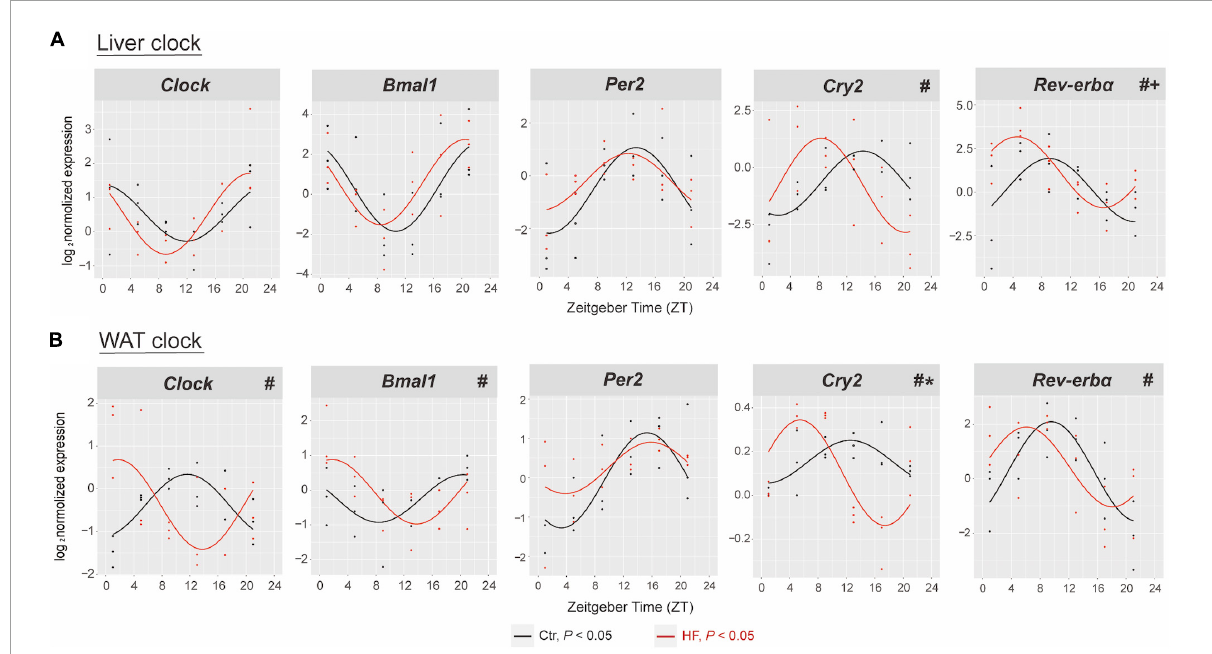
FIGURE2 High-fat diet disrupted the hepatic and adipose circadian rhythm in gestational mice. Mice were fed with a standard chow diet or a high-fat diet prior to pregnancy for 5 weeks, and throughout pregnancy. The morning of vaginal plug confirmed the pregnancy and was considered E0.5. On E18.5, the mice were killed at 4-h intervals over 24 h. Rhythmic pattern of circadian clock genes in the (A) liver and (B) WAT. The dots mark individual measurements in each zeitgeber time (ZT), and line represents cosinor regression fit. Rhythmic pattern of genes with significant differences in phase (#), amplitude (*), or MESOR (+) derived from CircaCompare ( n = 2–3/time point). Ctr, standard chow diet-fed pregnant mice; HF, high-fat diet-fed pregnant mice; WAT, white adipose